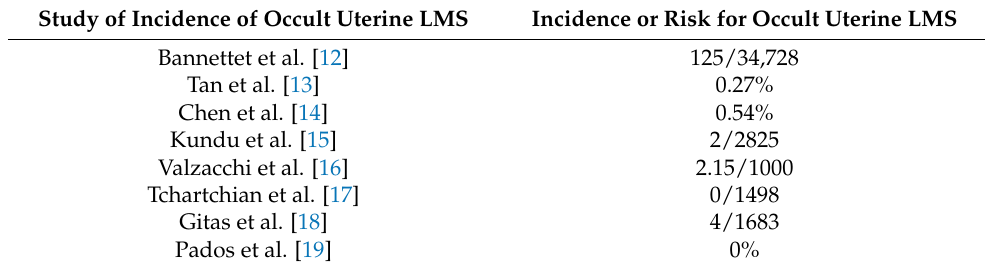
Table 1. Incidence and risk for occult uterine leiomyosarcoma (LMS).